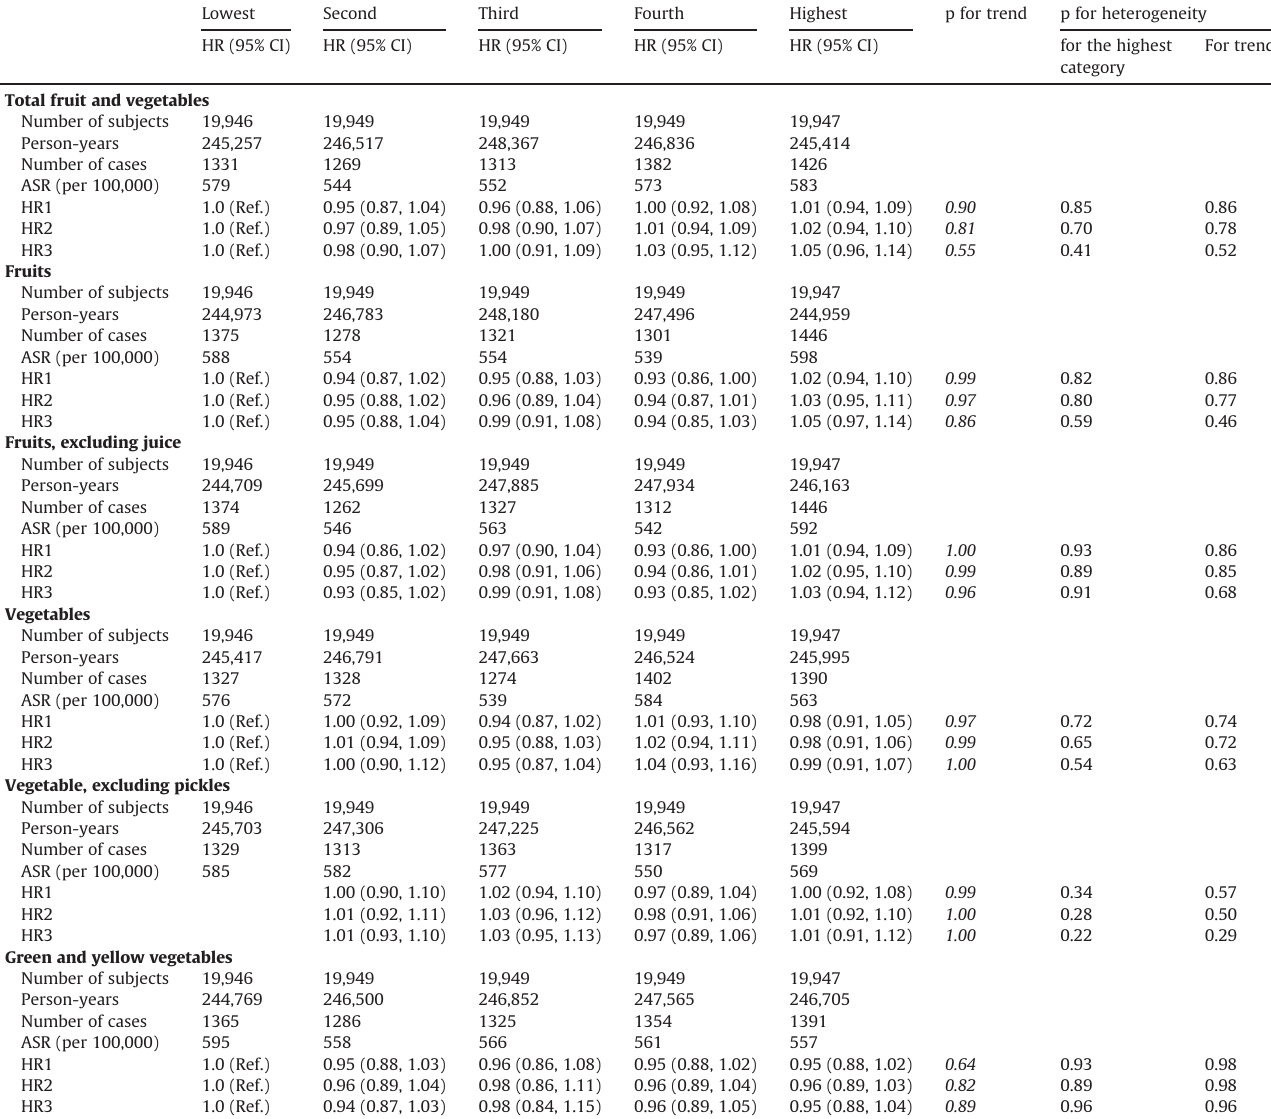
Table 2-2 Pooled analysis of overall cancer incidence according to quintile of fruit and vegetable consumption in Japanese women,1990 e 2006. Lowest Second